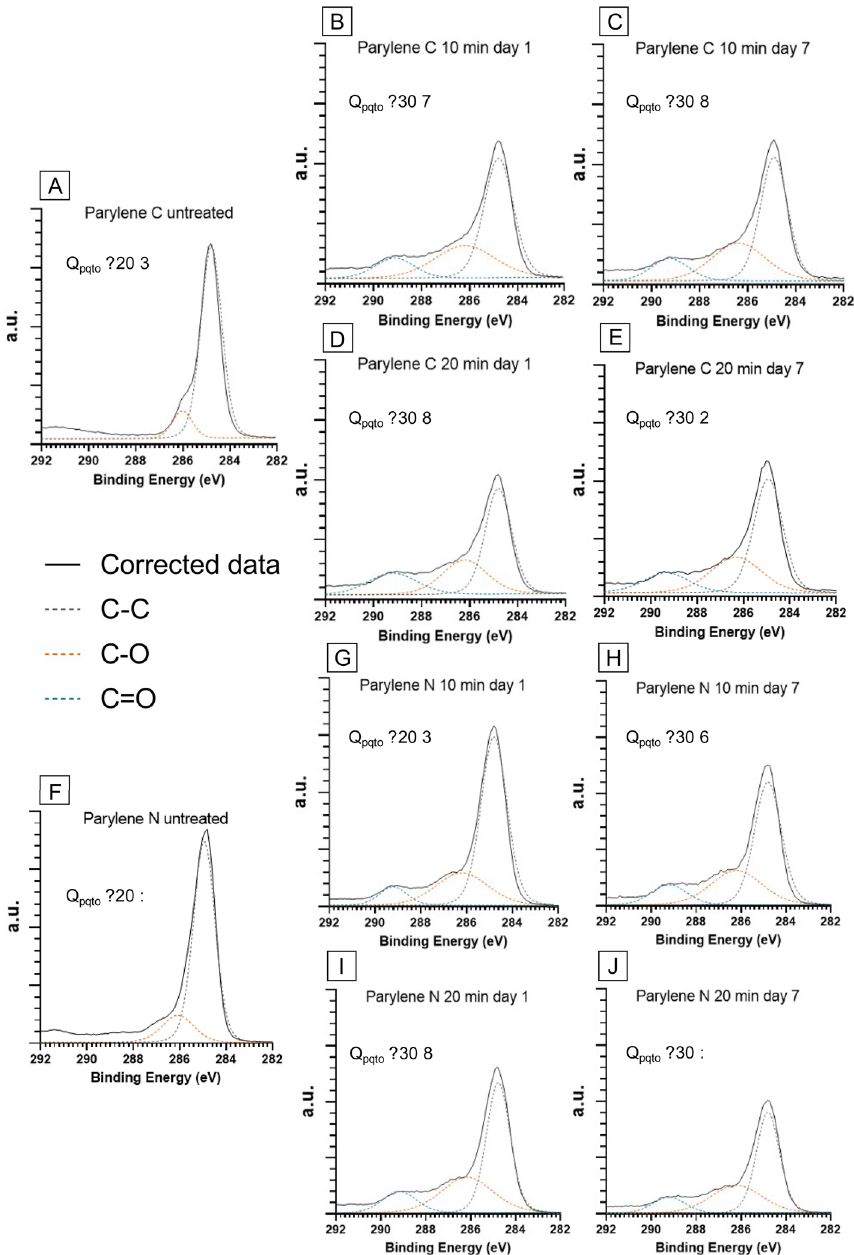
Figure 9. XPS visualization of high-energy tails associated with carbon bonding to oxygen for Parylene C ( A–E ) and Parylene N ( F–J ) membranes with different treatments on day 1 and day 7 and corresponding normalized oxygen concentrations extracted from the survey scans. Continuous black lines in each graph correspond to the corrected data, and the dotted lines are Gaussian–Lorentzian fits for carbon–oxygen (orange and blue) and carbon–carbon (gray)